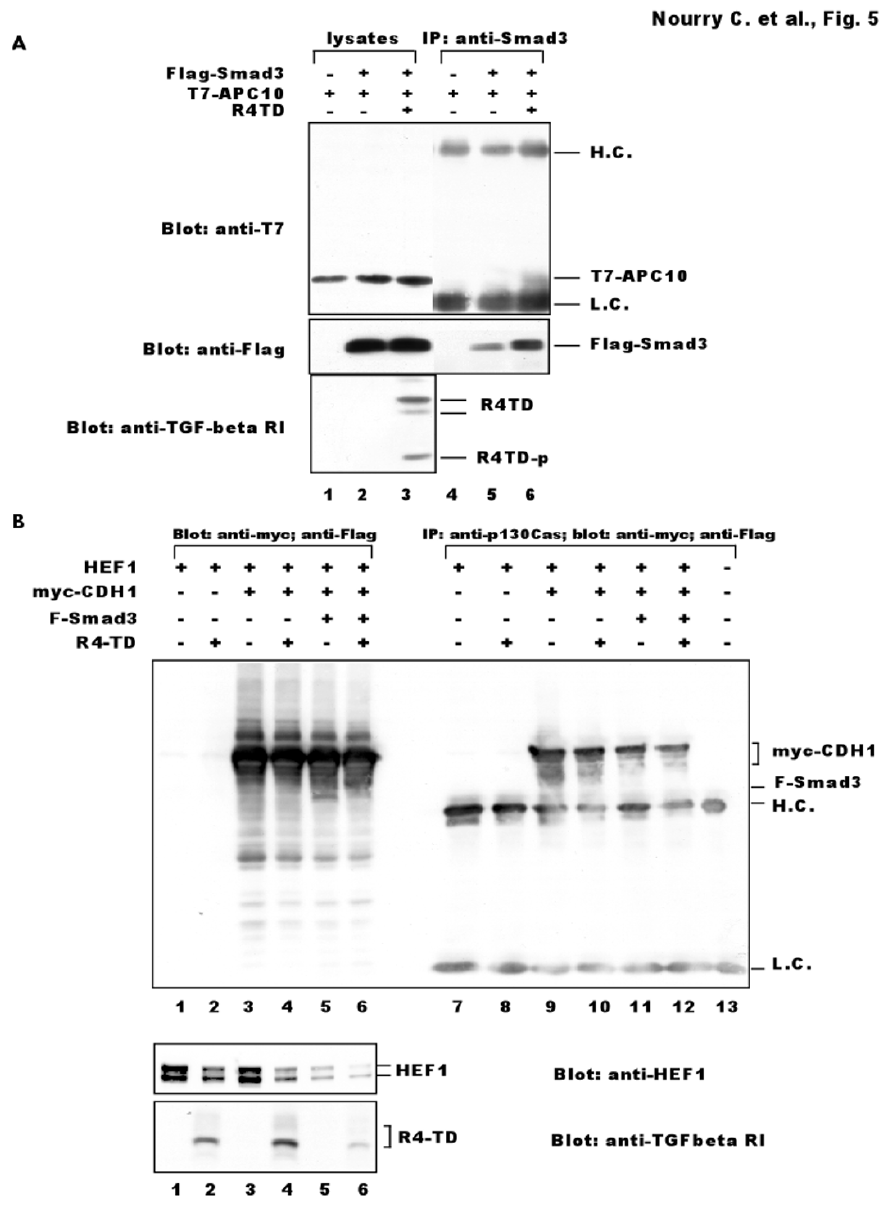
Figure 5 TGF- β type I receptor activation enhances Smad3 interaction with APC10 but does not alter CDH1 interac- tion with HEF1. (A) Smad3 interaction with APC10 is positively regulated by the activation of TGF- β type I receptor. Flag- Smad3 and T7-APC10 were co-expressed in the presence or absence of a constitutively active TGF- β type I receptor mutant R4T204D (R4TD). The interaction between Smad3 and APC10 was detected by immunoprecipitation of Smad3 with an anti- Smad3 polyclonal antibody followed by Western blot with anti-T7 (Top panel, lanes 4–6). The immunoprecipitated Flag-Smad3 was detected by anti-Flag antibody (middle panel). The expression of R4TD was detected by anti-TGF- β RI polyclonal antibody from Santa Cruz (Bottom panel). R4TD-p represents a potential cleavage product of R4. (B) HEF1 interaction with CDH1 Is not regulated by TGF- β type I receptor activation. The 293 cells were transiently transfected with myc-CDH1 and HEF1 in the presence or absence of Smad3 and R4TD, as indicated. The interaction between HEF1 and CDH1 was detected by immuno- precipitation with anti-p130Cas followed by Western blot with anti-myc (Top panel, lanes 7–13). The expression of myc- CDH1 and Flag-Smad3 was detected by Western blot by anti-myc and anti-Flag (Top panel, lanes 1–6). The expression levels of HEF1 was detected by anti-HEF1 (middle panel) and the levels of R4TD detected by Western blot with anti-TGF- β RI antibody (bottom